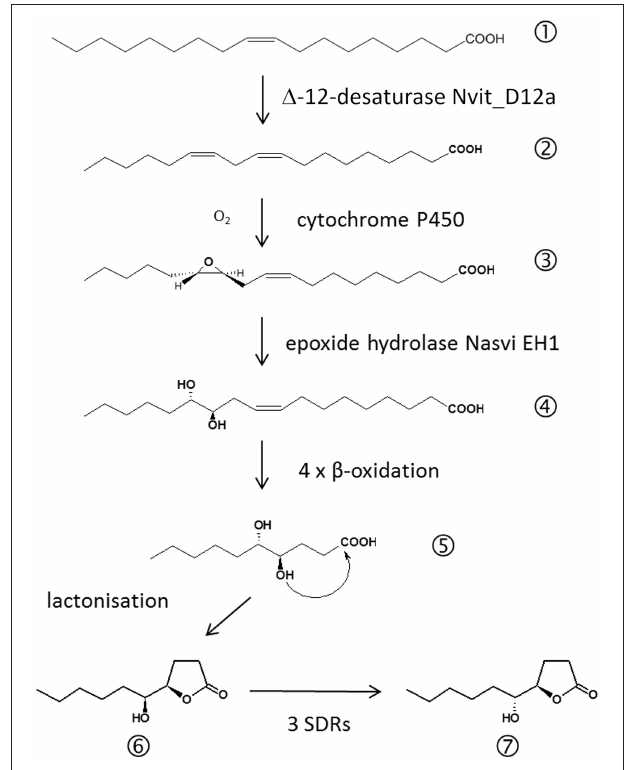
FIGURE 3 | Biosynthetic pathway of the major Nasonia male abdominal sex pheromone components. (1) oleic acid, (2) linoleic acid, (3) 12,13-epoxy-(9 Z )-octadecenoic acid, (4) 12,13-dihydroxy-(9 Z )-octadecenoic acid, (5) 4,5-dihydroxydecanoic acid, (6) (4 R ,5S)-5-hydroxy-4-decanolide (RS-HDL), (7) (4 R ,5 R )-5-hydroxy-4-decanolide